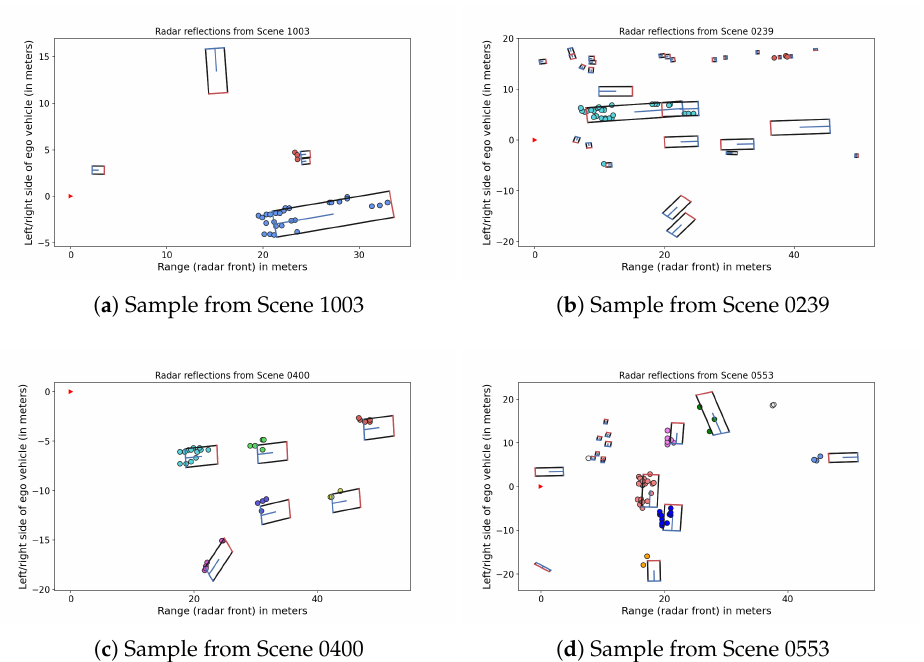
Figure 1. Samples with radar reflections (3 sweeps) and vehicle contours from selected scenes.